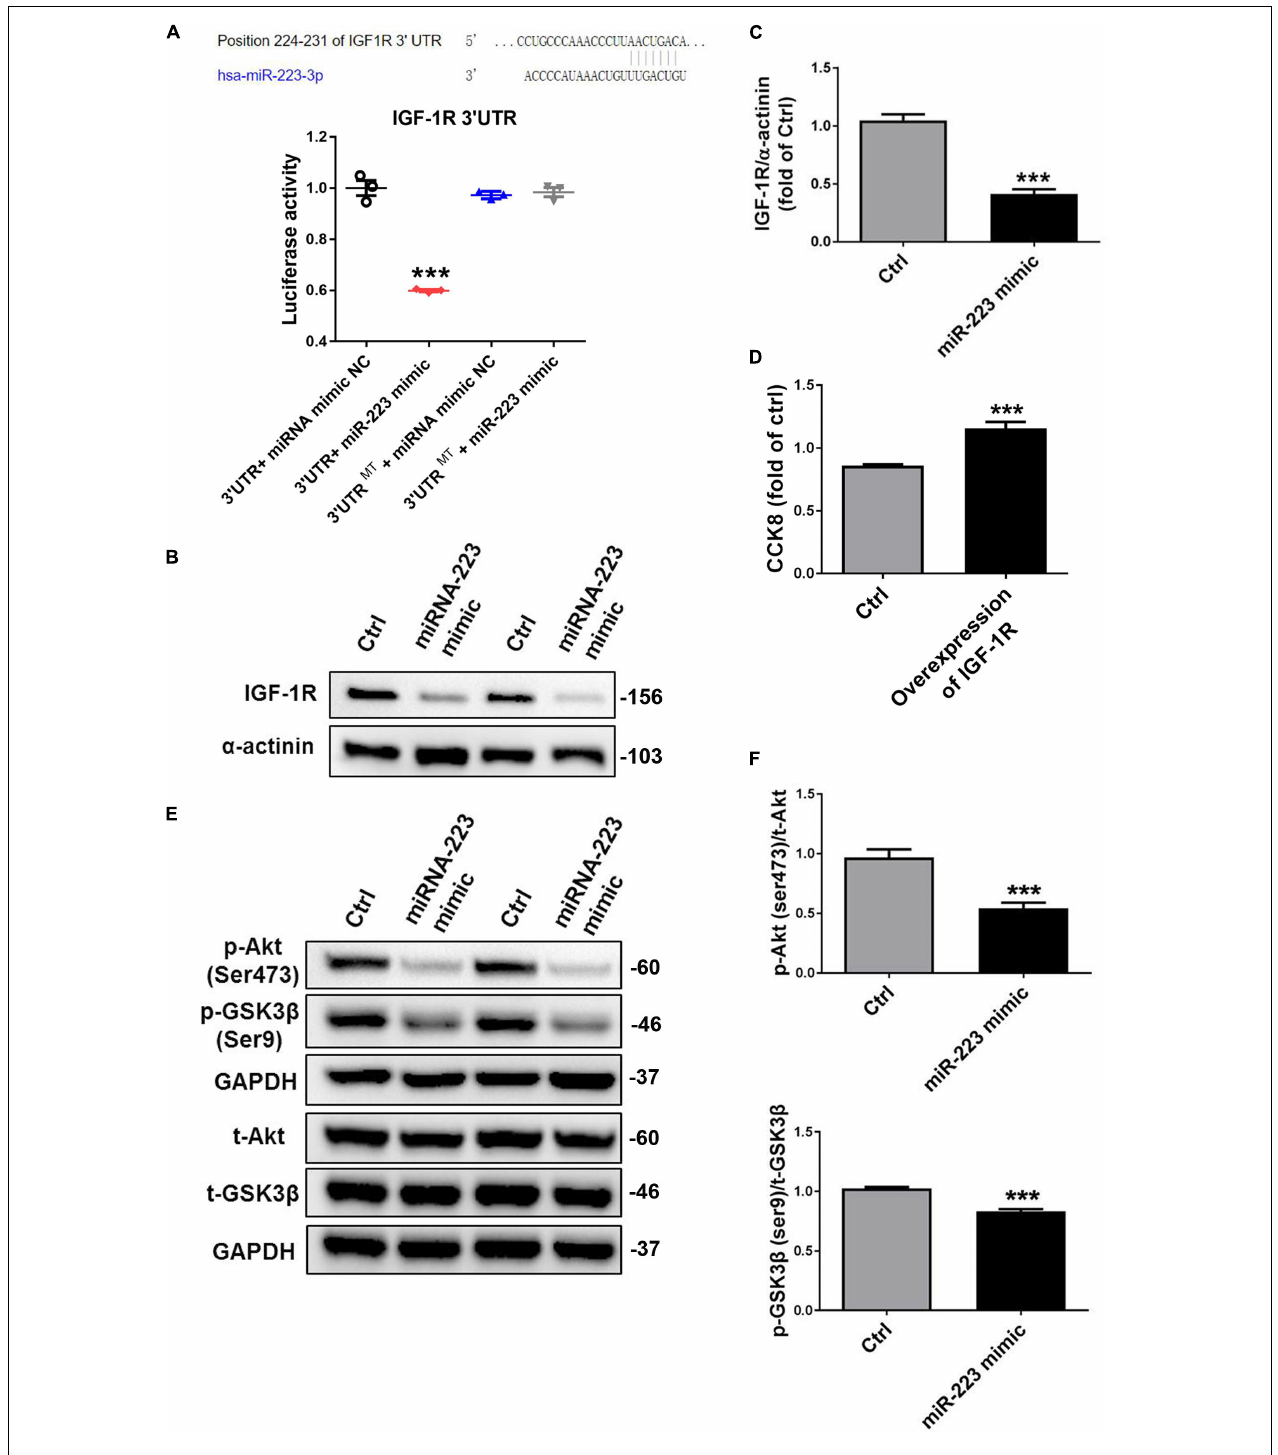
FIGURE 2 | MiR-223 directly targets the IGF-1R, which inhibits the phosphorylation of Akt and GSK3 β . (A) Bioinformatics analysis identified a binding site for miR-223 in the 3 (cid:48) -UTR of IGF-1R. Luciferase activity assay in VSMCs following introduction of IGF-1R 3 (cid:48) UTR or mutant 3 (cid:48) UTR (mut) with or without miR-223 mimic ( n = 3). VSMCs were transfected with miR-223 mimic for 48 h. (B,C) The expression of IGF-1R in VSMC was detected with western blot analysis. (D) The rate of proliferation was determined by CCK8 assay in VSMCs transfected with overexpression of IGF-1R. (E,F) The phosphorylation of Akt and GSK3 β in VSMC was determined with western blot analysis. Data are presented as mean ± SD ( n = 6). Comparisons between two groups were analyzed using unpaired nonparametric Student’s t -test. * P < 0.05, ** P < 0.01, *** P < 0.001 vs Ctrl (miR-NC).